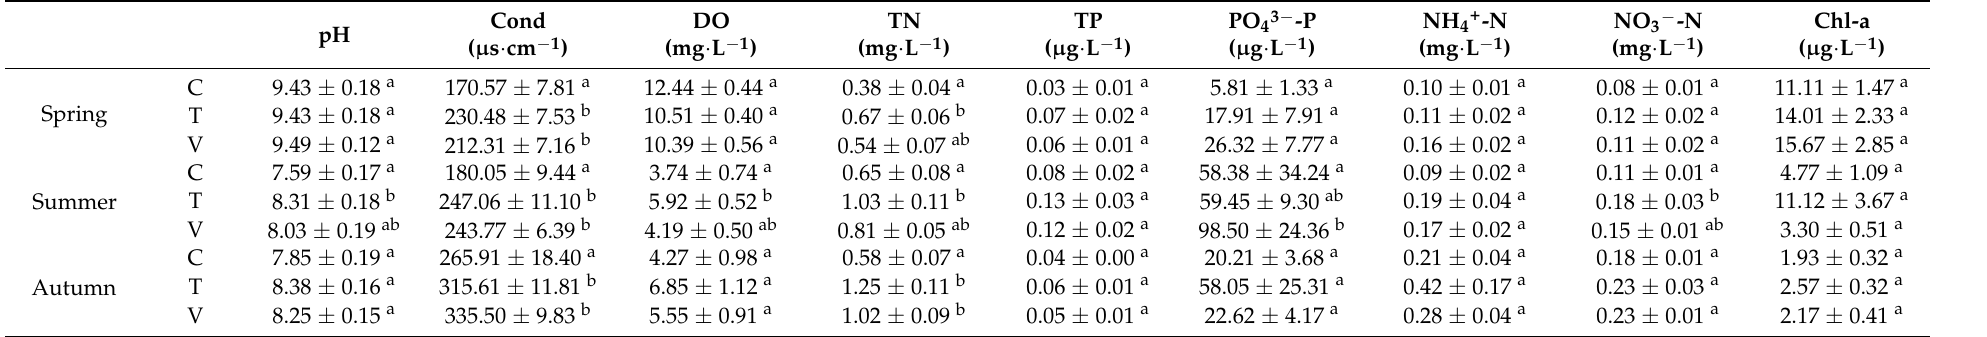
Table 1. Mean water quality for all treatments during the experiment. Values are mean ± SE. C, ambient temperature; T, +4 °C constant warming; V, variable warming. The letters above the data represent significant differences between treatments ( p < 0.05, Tukey’s